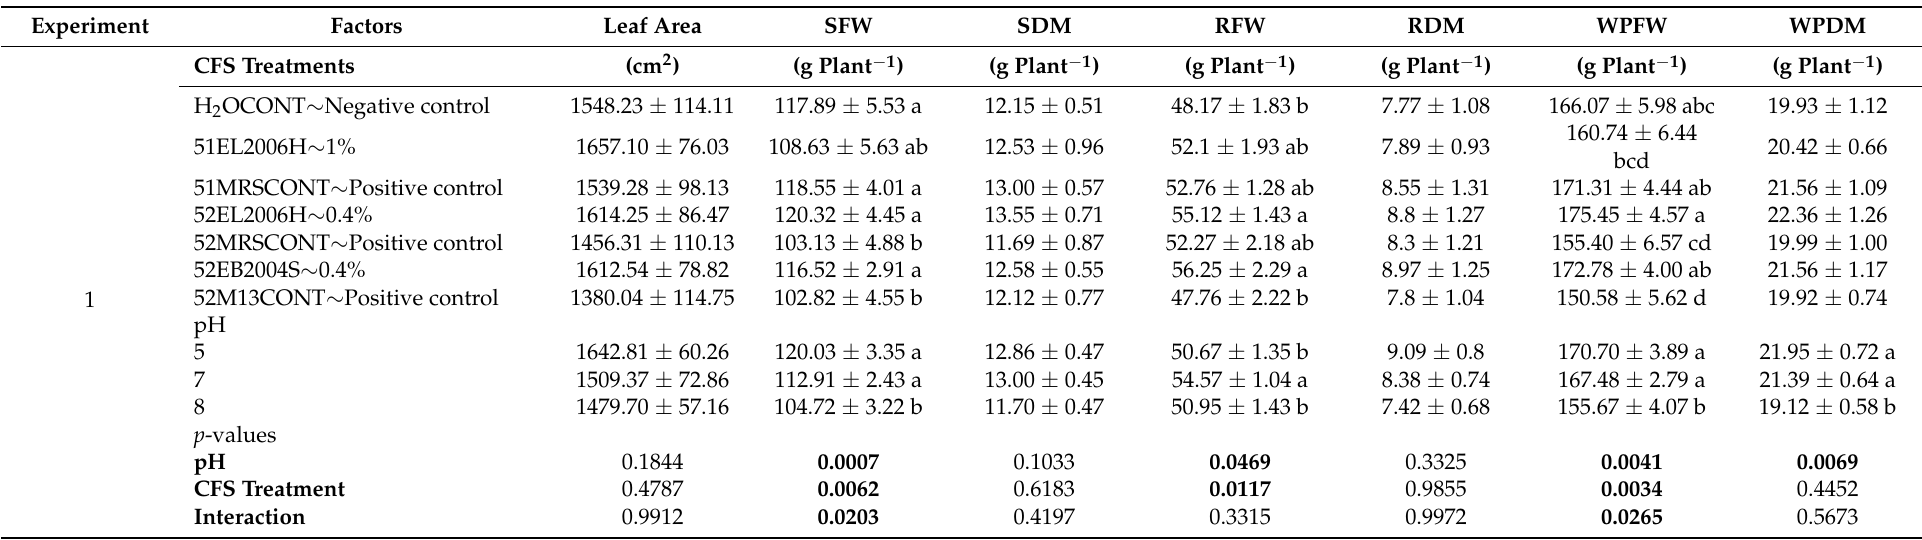
Table 2. A two-way ANOVA on the response of potato to CFS and pH treatments on leaf area, shoot fresh weight (SFW*), shoot dry matter (SDM*), root fresh weight CFS treatments obtained at pH 5; Experiment 2 represents CFS treatments obtained at pHs 7 and